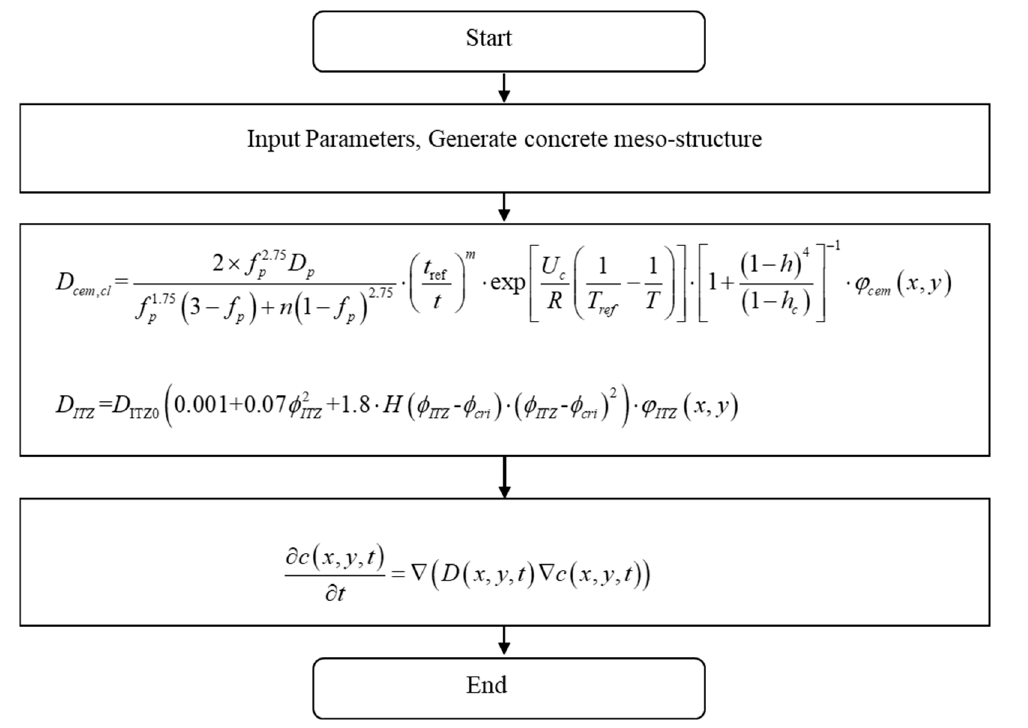
Figure 3. Numerical solution flow chart. Table 1. Numerical simulation ‐ related parameters.